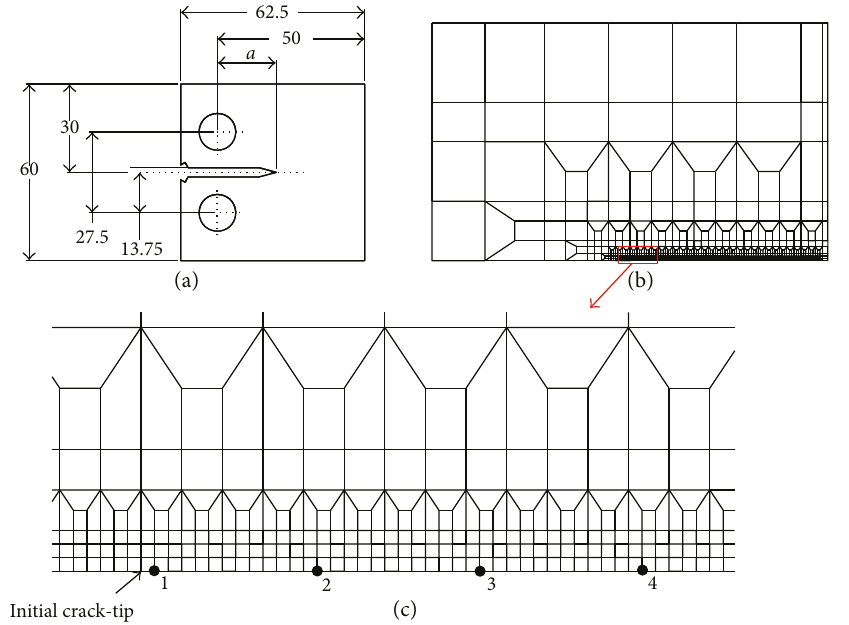
Figure 3: (a) Sketch of a CT specimen (initial crack length a = 25 mm, width W = 50 mm, and thickness B = 12 5 mm) and (b) the FE mesh (a half of the specimen is modeled), and (c) points 1, 2, 3, and 4 correspond to the four integration points located along the crack growth path (the distance between two adjacent points is 1.2mm), and the arrow indicates the initial crack-tip of the CT